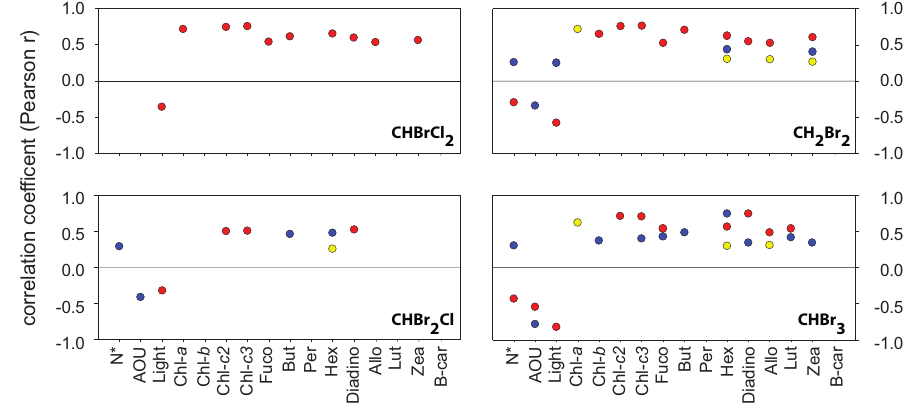
Fig. 6. Results of cross-tabulation tables of Pearson r correlation coefficients for bromocarbons vs. quasi biological markers (N*, AOU and light transmission) and marker pigments. Data are clustered into three water masses: Recently upwelled waters (blue), aged upwelled waters (yellow) and open ocean waters (red). For the abbreviation of the marker pigments see Table 1.